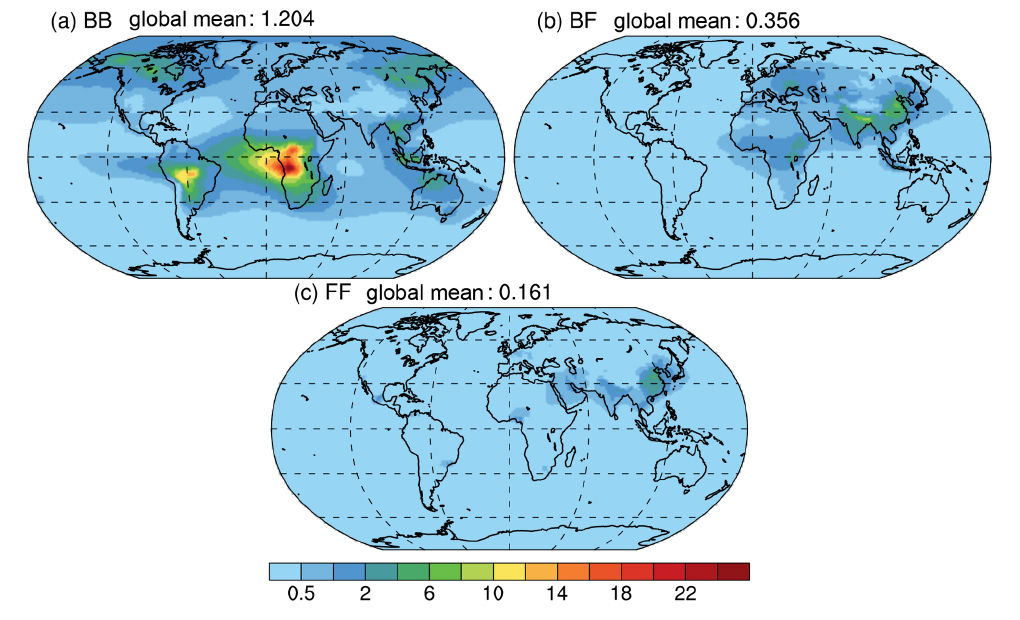
Figure 1. The column burdens of POM from (a) biomass burning (BB), (b) biofuel (BF), and (c) fossil fuel emissions. Panels (a) and (b) represent BrC in the BRC, BRC_CNST, and BRC_BL model runs. The units are in mgm − 2 and the values are a 9-year average from 2003 to